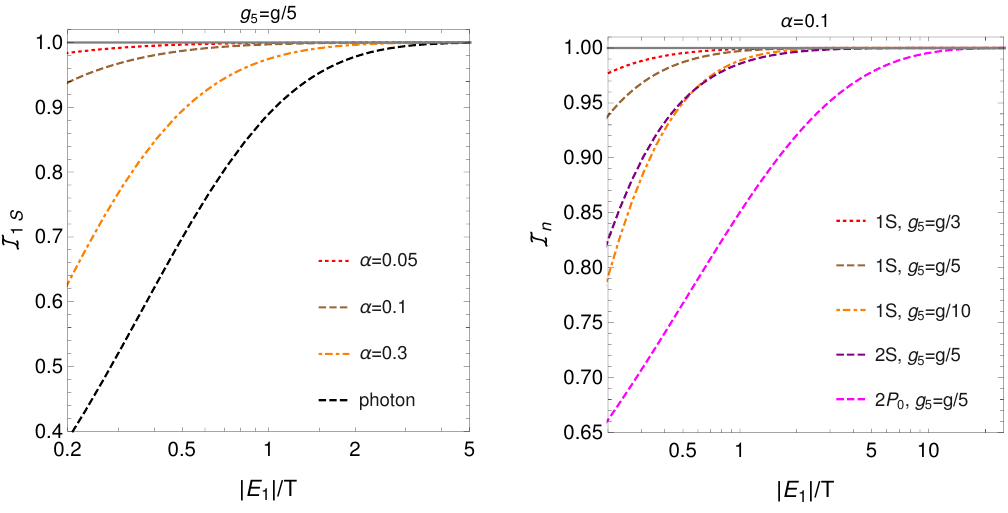
Figure 10 . Left: I n for the scalar mediator for three values of α = 0 . 05 , 0 . 1 , 0 . 3 displayed with the dotted-red, dashed-brown and dotted-dashed orange curves respectively. The black-dashed line corresponds to the I n for the vector mediator model. Right: I n for the ground state, for different values of g/g 5 , and comparison with the 2 S and 2 P 0 bound